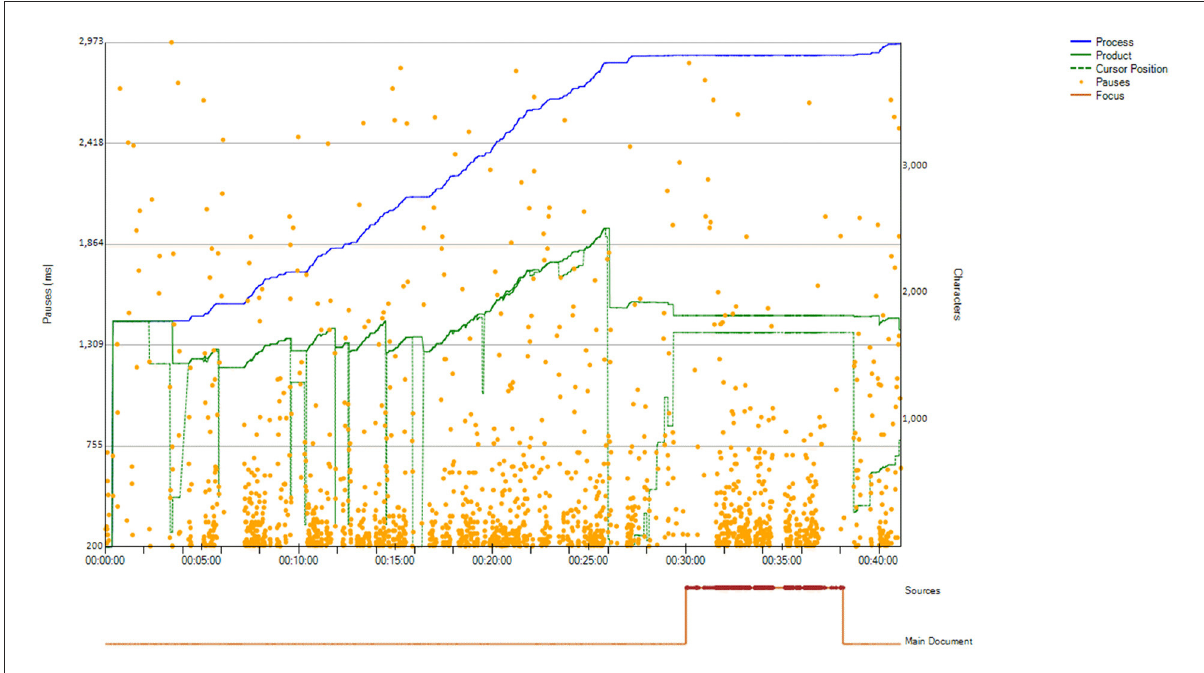
FIGURE1 Example of an Inputlog process